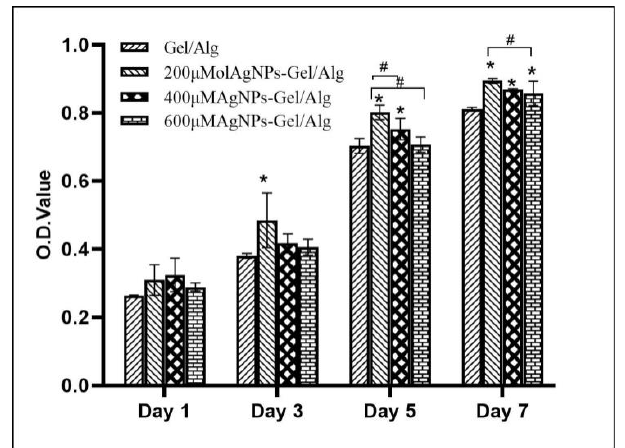
Figure 6. Proliferation of MC3T3-E1 cells on AgNP–Gel / Alg sca ff olds with di ff erent concentrations of AgNPs. * p < 0.05 vs. control group; # p < 0.05 vs. 200 µ M AgNP–Gel / Alg group.